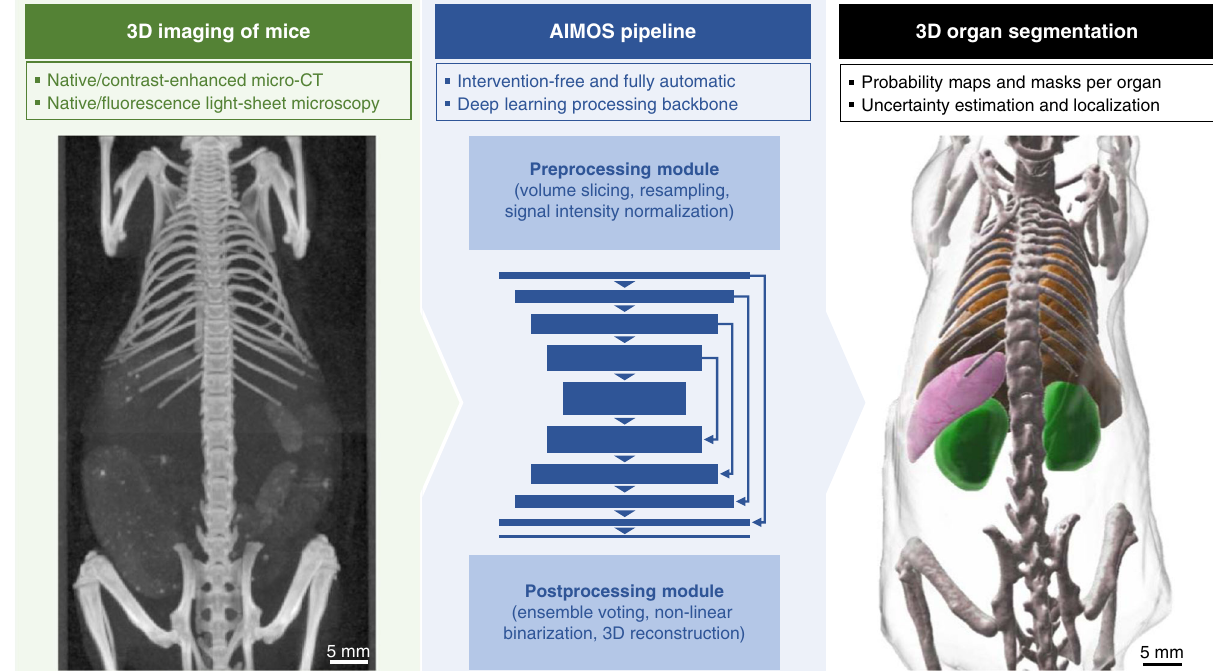
Fig. 1 The AIMOS processing pipeline. AIMOS is a fully automatic, end-to-end deep learning pipeline that segments multiple organs of mice in 3D scans across different imaging